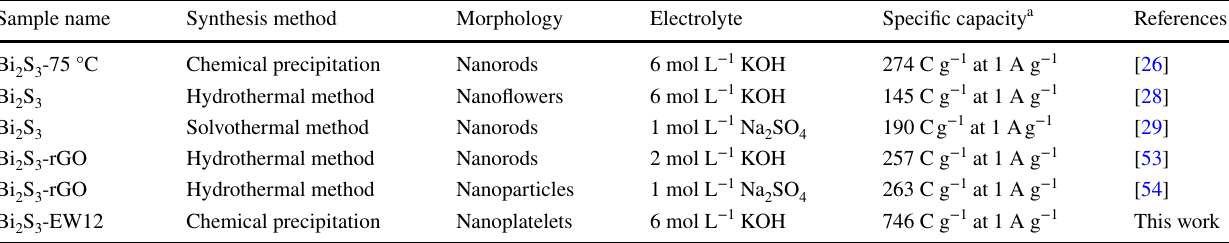
Table 2 Comparison of electrochemical capacities of Bi 2 S 3 -based materials synthesized under different conditions